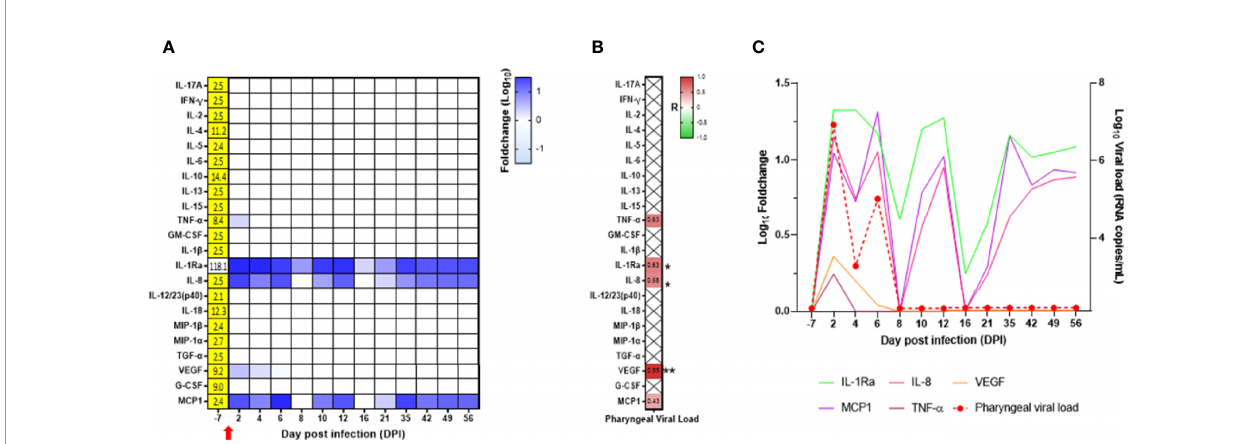
FIGURE 7 | Cytokine analyses in the neonate oropharyngeal compartment. (A) Heatmap for the evolution of cytokines over time (in the log of fold change from the baseline). Variations are shown on a blue scale. Basal concentrations (pg/ml) are shown on the left side of the heatmap. Highlighted yellow values correspond to the detection threshold. (B) Spearman correlation analysis between SARS-CoV-2 viral RNA load in the oropharyngeal compartment and the kinetics of cytokines in the same compartment was performed. The obtained correlation factors, which have been determined on the whole kinetics, are shown on the heatmap with a red to